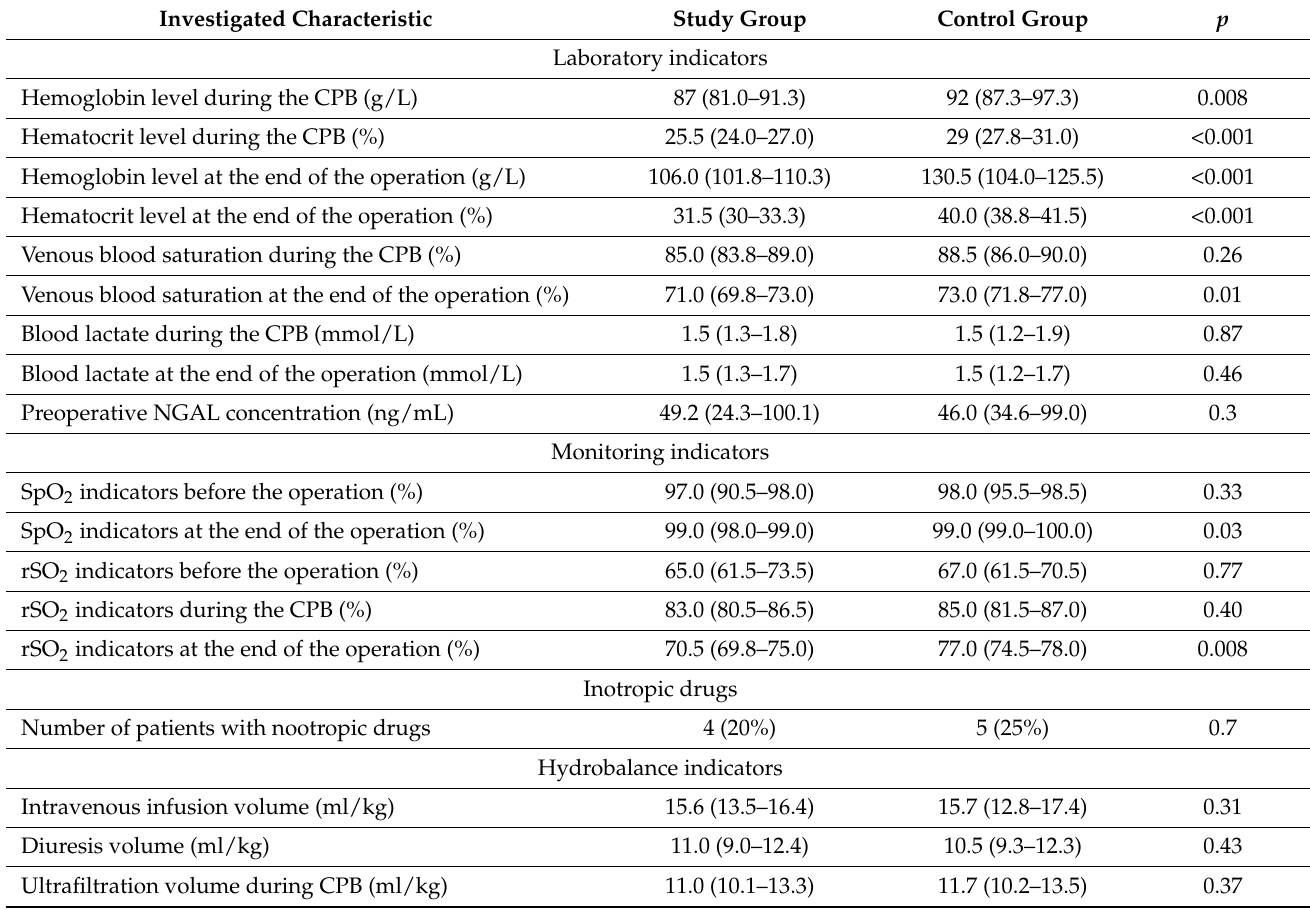
Table 2. Characteristics of the factors of the intraoperative